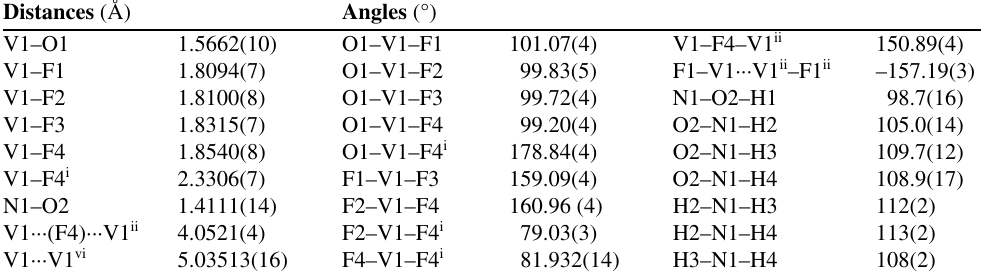
Table 2. Selected interatomic distances and angles.